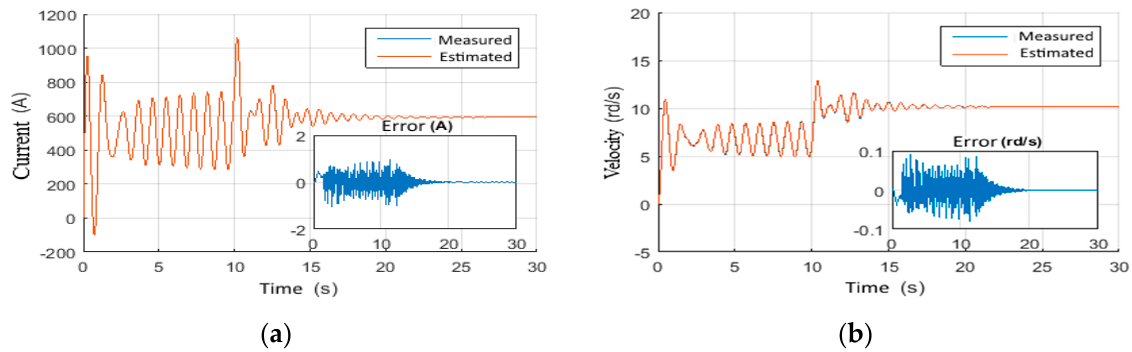
Figure 15. Measured and estimated variables by the designed observer: ( a ) Top-drive current, ( b ) Top-drive velocity.